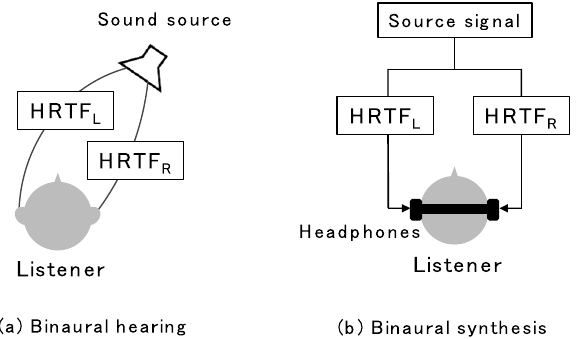
Figure 2. ( a ) Binaural hearing of a sound source. ( b ) Virtual sound image presentation by binaural synthesis via signal processing with a source signal and head-related transfer functions